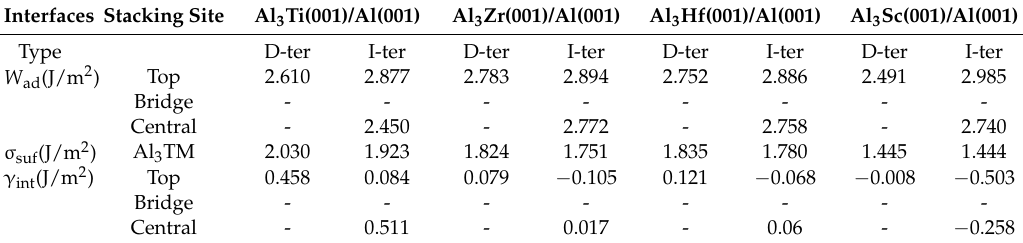
Table 4. Griffith rupture work ( W ad ), surface energy ( σ suf ), and interfacial energy ( γ int ) of